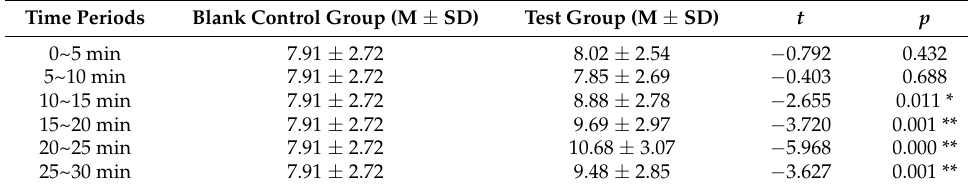
Table 2. Paired samples t -test for BF.